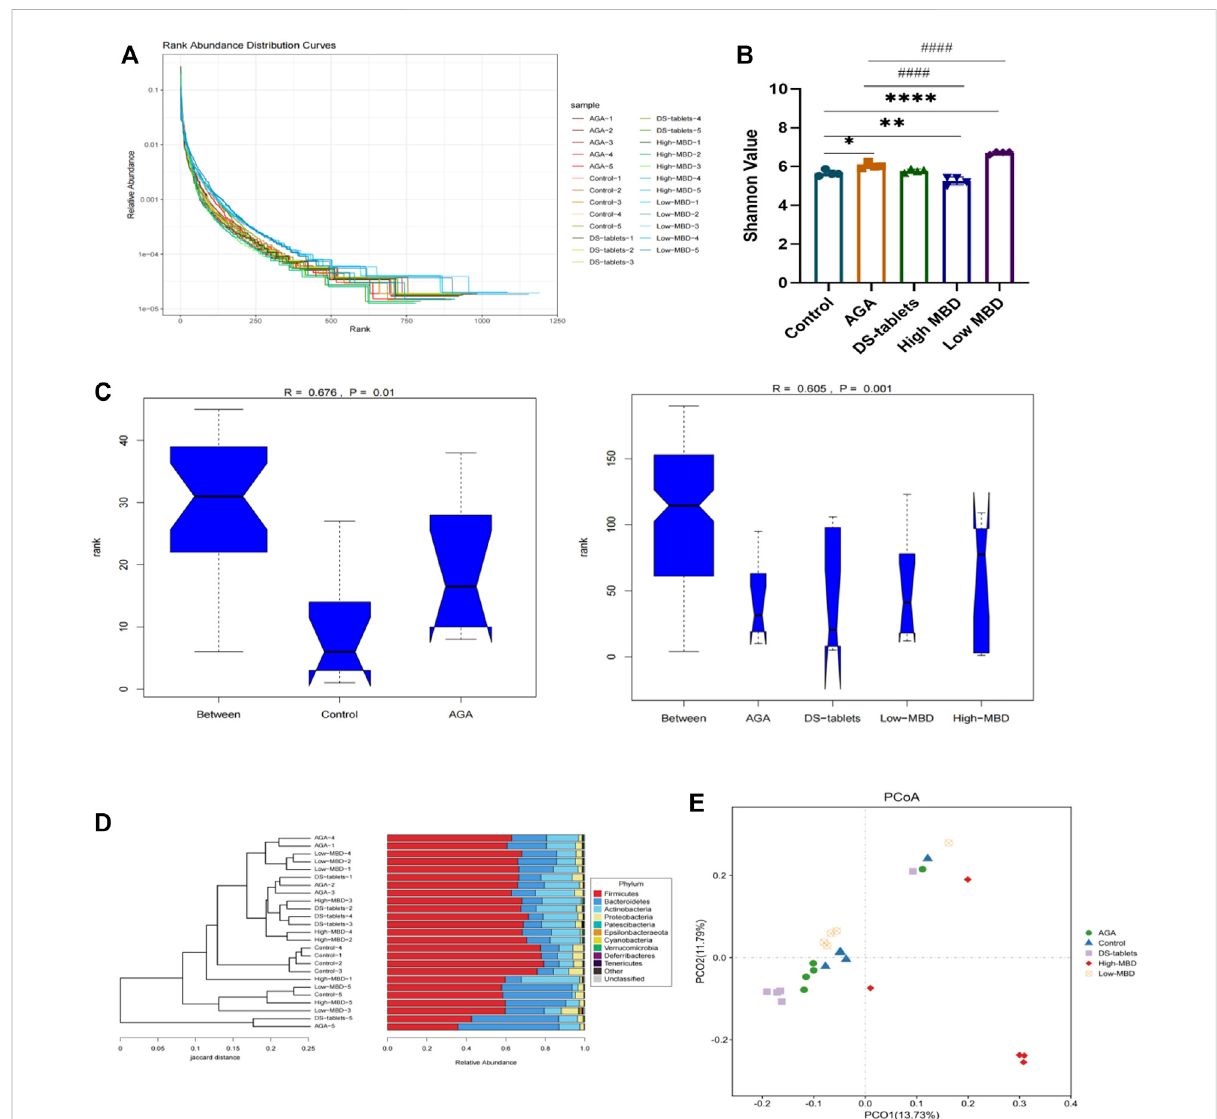
FIGURE 7 MBDregulatedthemicrobialcommunitystructure. (A) Rankabundancecurvesprovideavisualrepresentationoftherichnessanduniformityof the taxa contained in the sample. (B) Effects of MBD on Shannon indices. (C) Analysis of similarity (ANOSIM) is a non-parametric test of the structure of microbial communities. The fi gure “ between ” is a visualization of the values of the distribution of distances between groups. Generally, R > 0.75 : large differences; R > 0.5 : moderate differences, R > 0.25 : small differences. The con fi dence level of the statistical analysis is expressed as the p -value, with p < 0.05 indicating statistical signi fi cance. (D) Hierarchical clustering analysis at the OTU level. (E) Based on data results